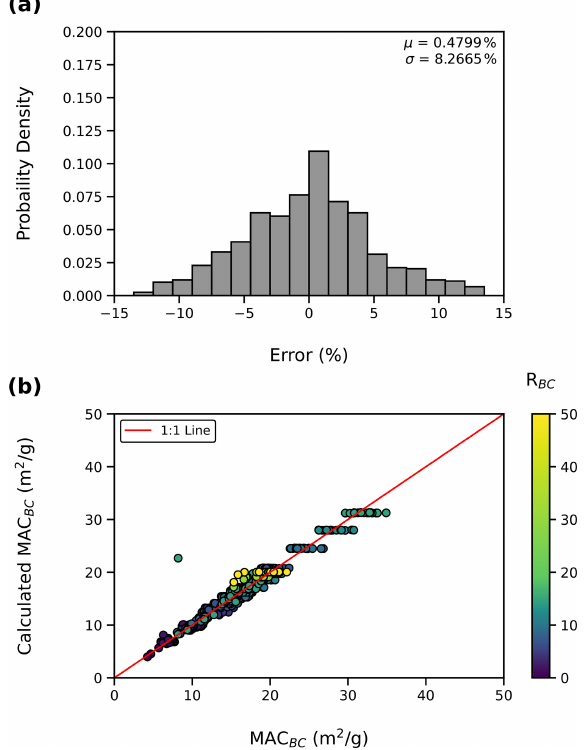
Figure 5. (a) Residual plot of fitting of Eq. (3). On average, Eq. (3) overestimates MAC BC by 0.47%, with a standard deviation of 8.26% ( µ and σ , respectively). (b) MAC BC calculated using Eq. (3) as a function of MAC BC from ADDA. Equation (3) accurately pre- dicts MAC BC from the mixing state and morphology of the BC ag- gregates used to develop Eq. (3), but relative errors increase with increased R BC . It should be noted that the outlier point is a thickly coated aggregate with ρ BC (cid:29) 1 and κ coat > 0 . 00, representing the limitations of the developed framework.